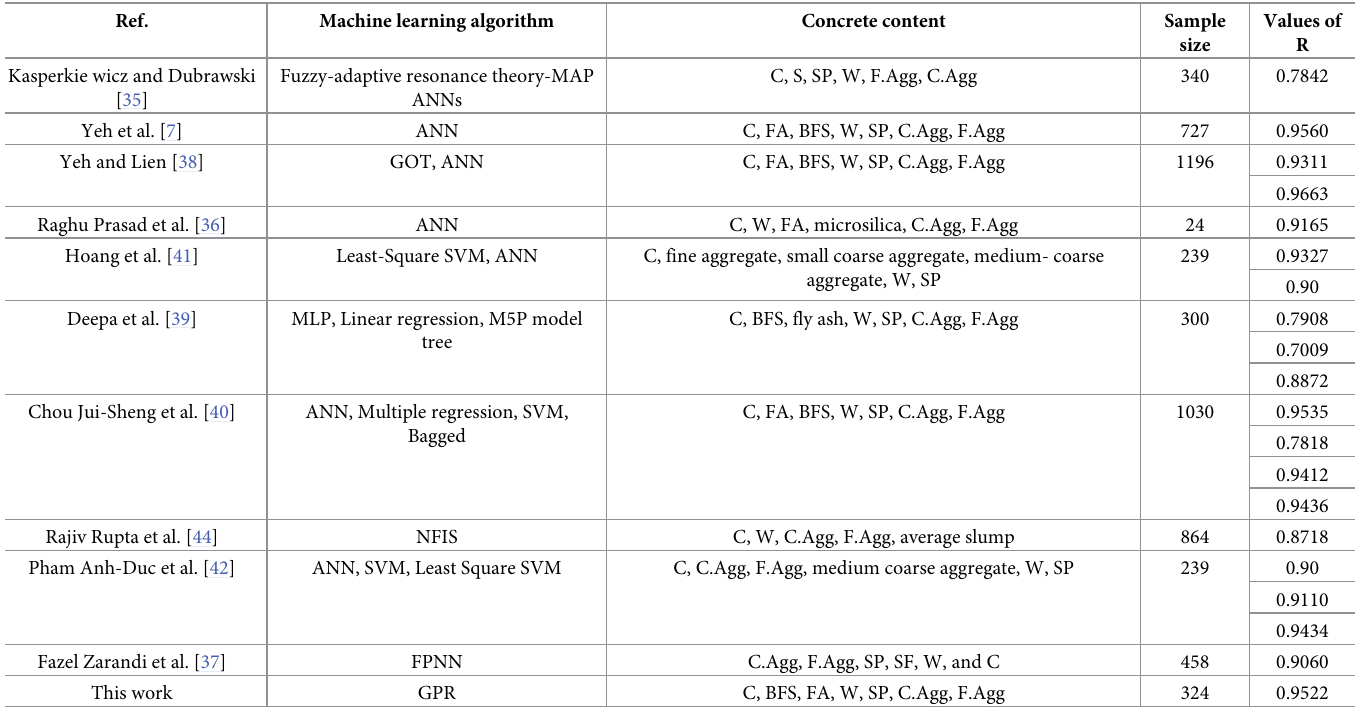
Table 2. Comparison with literature for prediction of compressive strength of HPC.